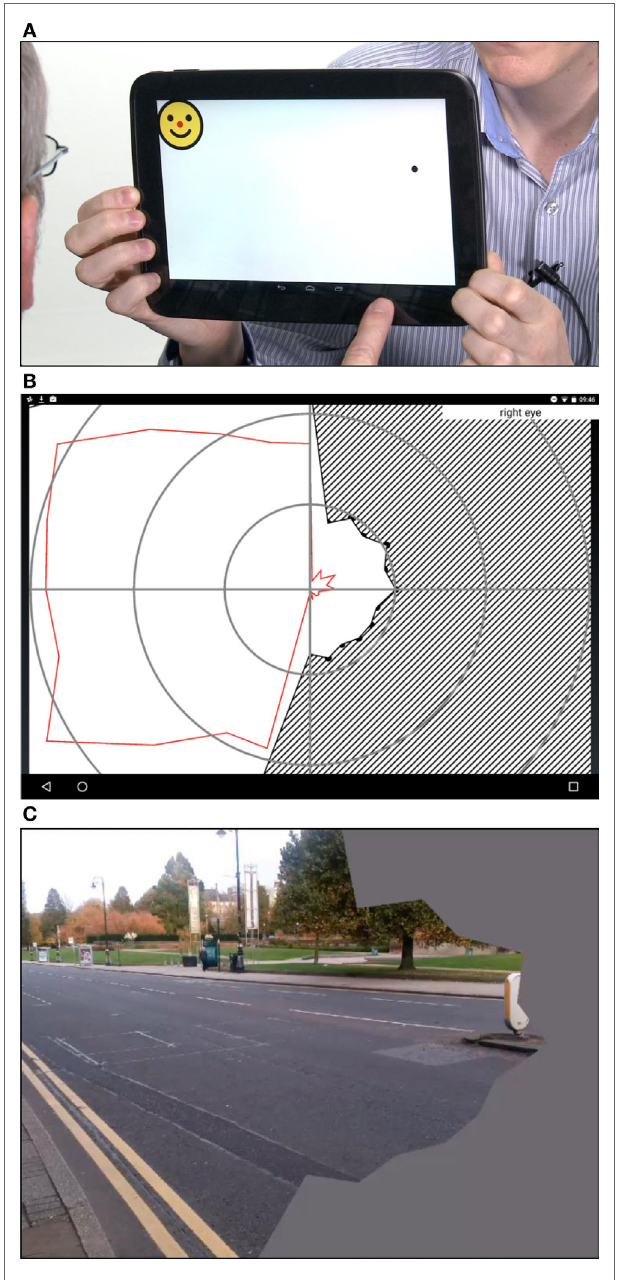
FigUrE 2 | (a) The StrokeApp Visual Field test. The fixation target is the red nose of the smiling face graphic. The fixation target moves to the extreme corners of the device screen and the black circular target emerges from the periphery toward fixation. The peripheral target (black circle) subtends a similar angle to the Goldmann III target setting. The patient is encouraged to tap anywhere on the screen at the moment they detect the emerging peripheral target. The tester observes patient fixation, and if a fixation loss is detected, the screen is swiped to delete the previous input and re-test that point or quadrant. (B) The diagonal hashed lines indicate field defect once reaction time has been accounted for. The red line indicates limit of the visual field before reaction time has been accounted for. (C) StrokeSim. The detected perimetry plot is transposed as a digital filter to the feed from the device back-facing camera. The field within the defect is averaged to a single